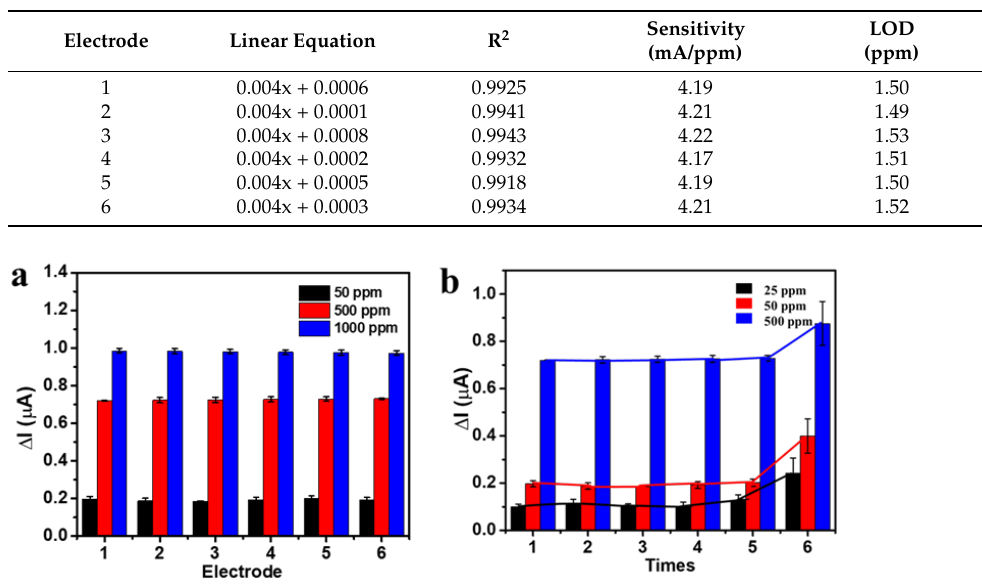
Figure 6. Stability ( a ) and reproducibility ( b ) of the MMIP – gluten-modified electrode .